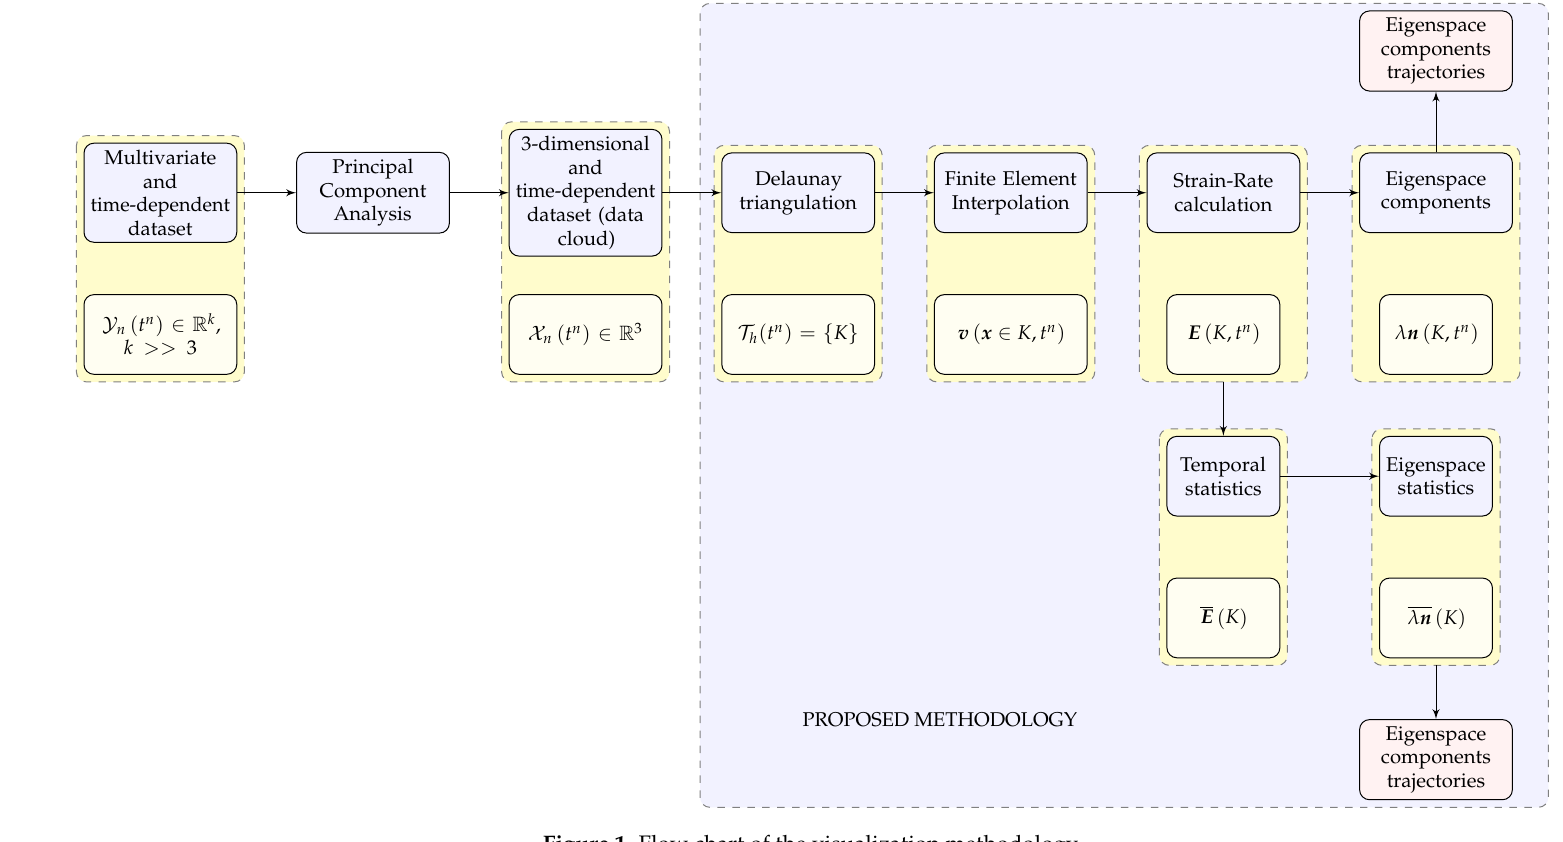
Figure 1. Flow chart of the visualization